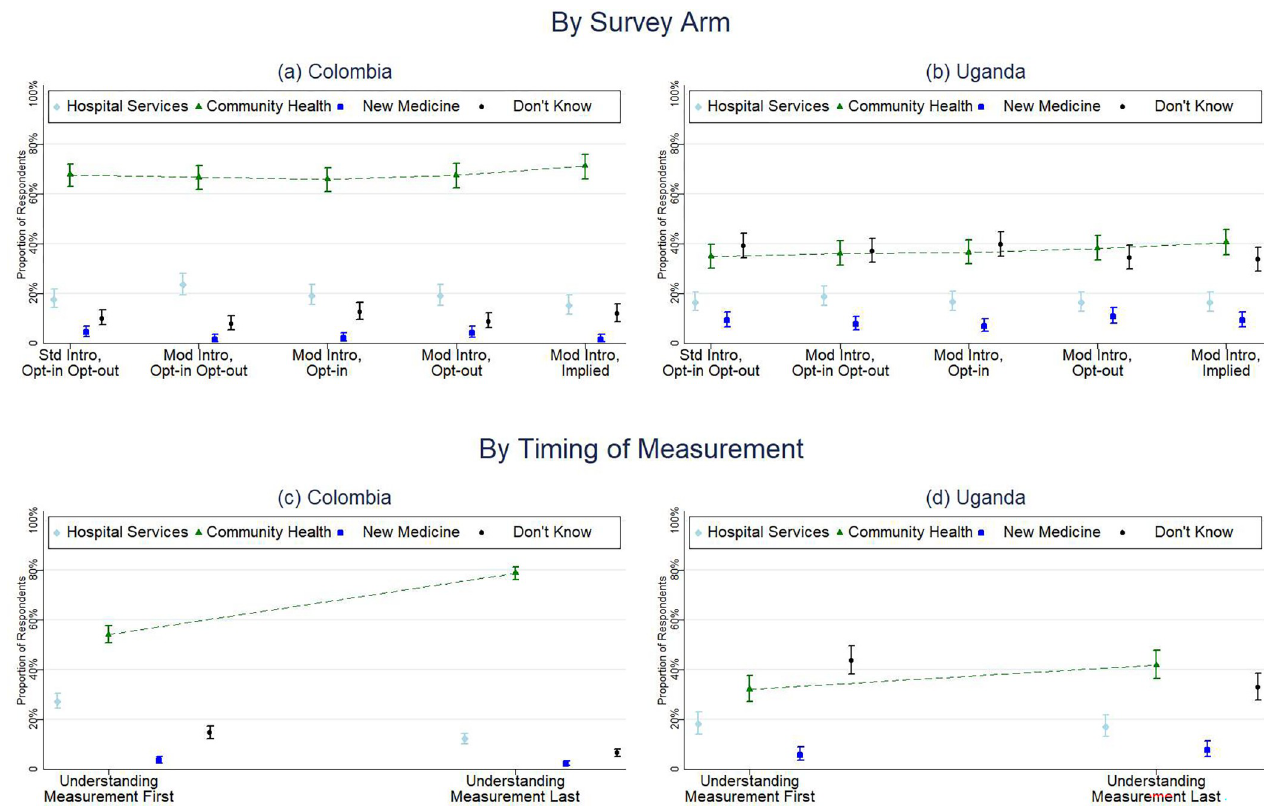
Fig 3. Understanding of survey purpose by study arm and timing of measurement in Colombia and Uganda.